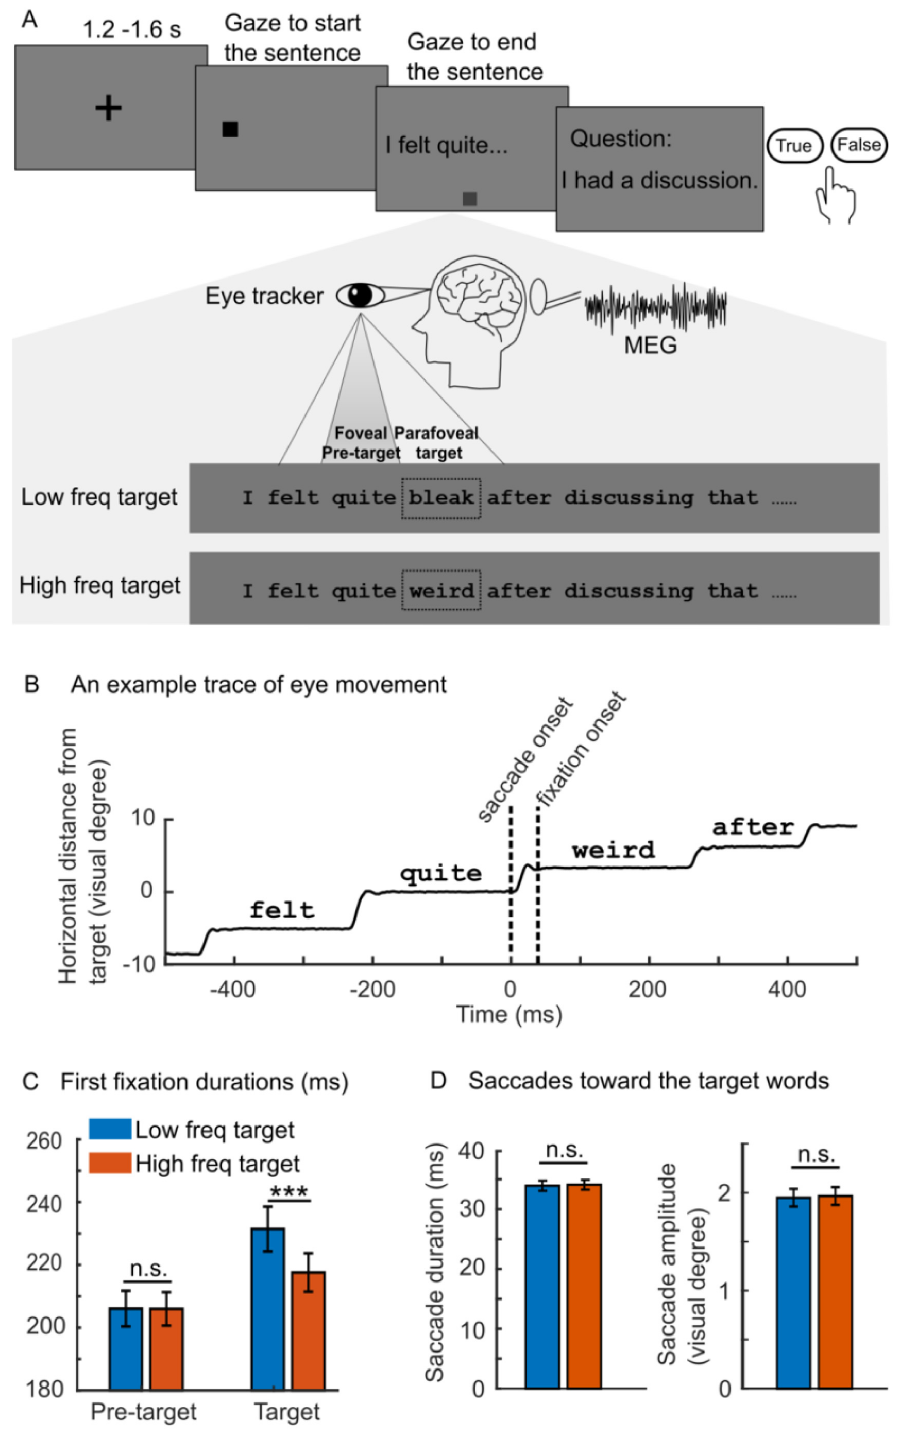
Fig 1. The natural reading paradigm and eye movement metrics. (A) Eye positions and brain activity were recorded simultaneously when participants ( N = 38) read 228 one-line sentence. All sentences were plausible with unpredicted target words of either low or high lexical frequency (the dashed rectangle is for illustration only). One-quarter of the sentences were followed by a comprehension question about the just presented sentence to ensure careful reading.